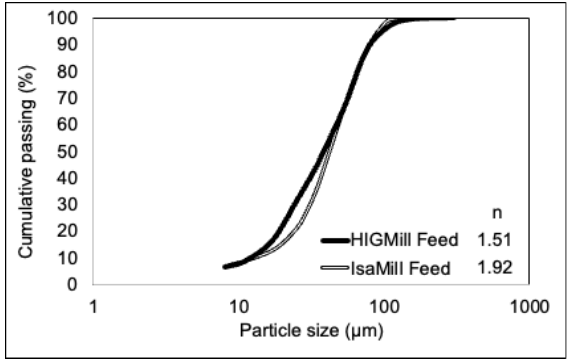
Figure 9. Feed size distributions of the two mills.